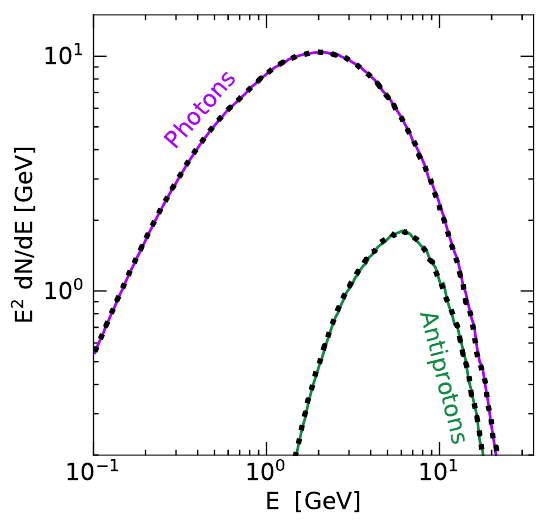
Figure 3 . An illustration of the minimal impact of the mediator’s spin on the gamma-ray and antiproton spectra from dark matter annihilations. The solid and dotted curves represent the spectra predicted for a spin-1 or spin-0 mediator, respectively, for the representative case of 50 GeV dark matter particles annihilating to a pair of 20 GeV hidden sector particles which decay to b quark pairs. The solid and dotted curves are virtually indistinguishable from each other in this case, and across the entirety of the parameter space relevant to this